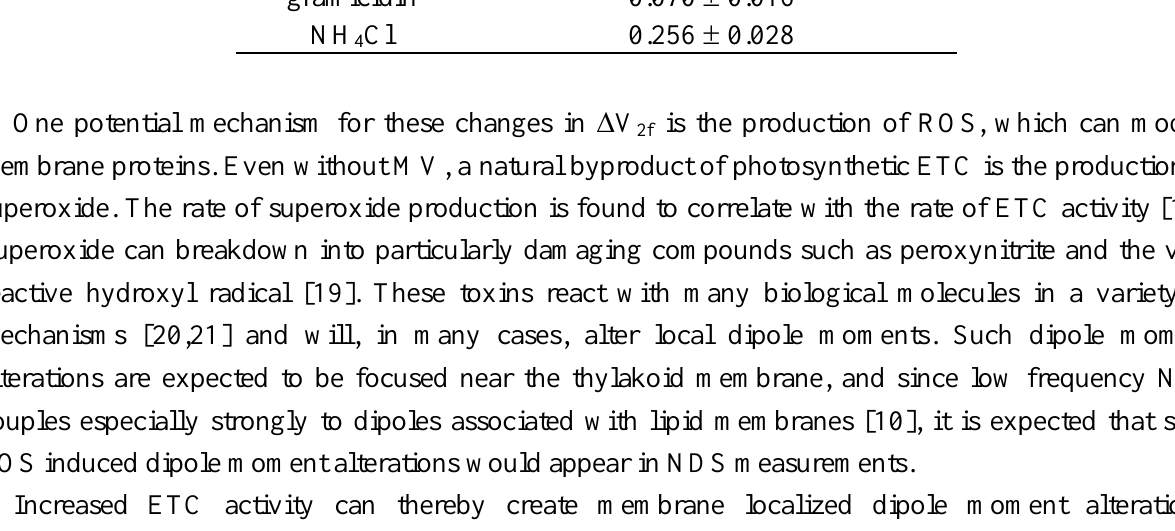
to O production (from data in Figure 5). The control and 2f 2 scales linearly with O 2f Cl ratio is significantly larger than the gramicidin 4